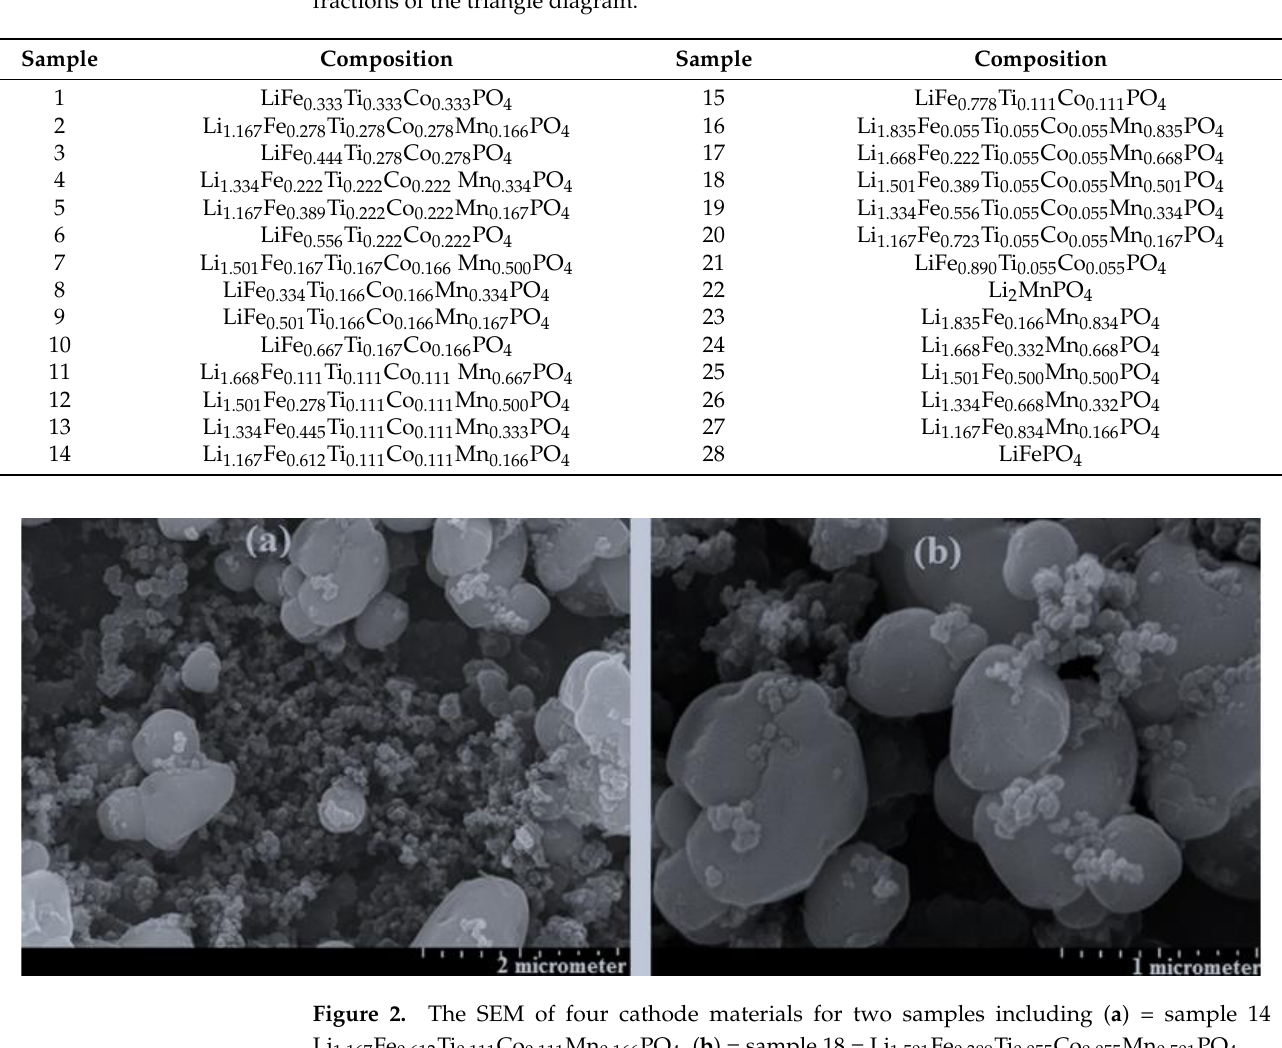
Table 2. Twenty-eight different compositions using the lever rule, stoichiometric weights and mole- fractions of the triangle diagram.